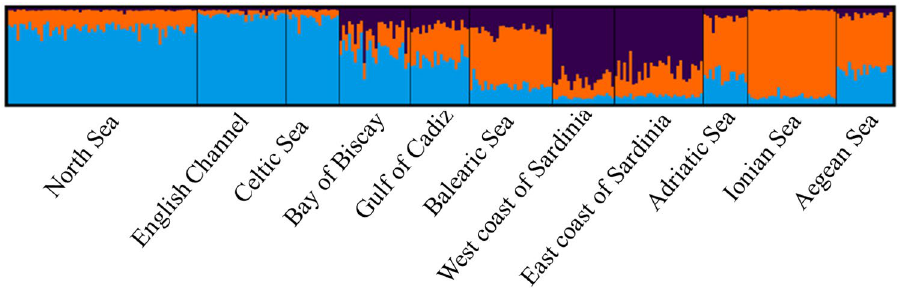
Figure 2. Structure analysis based on microsatellite data revealing three genetic clusters (blue = Atlantic cluster, orange & violet = Mediterranean cluster) for individuals from the sampled